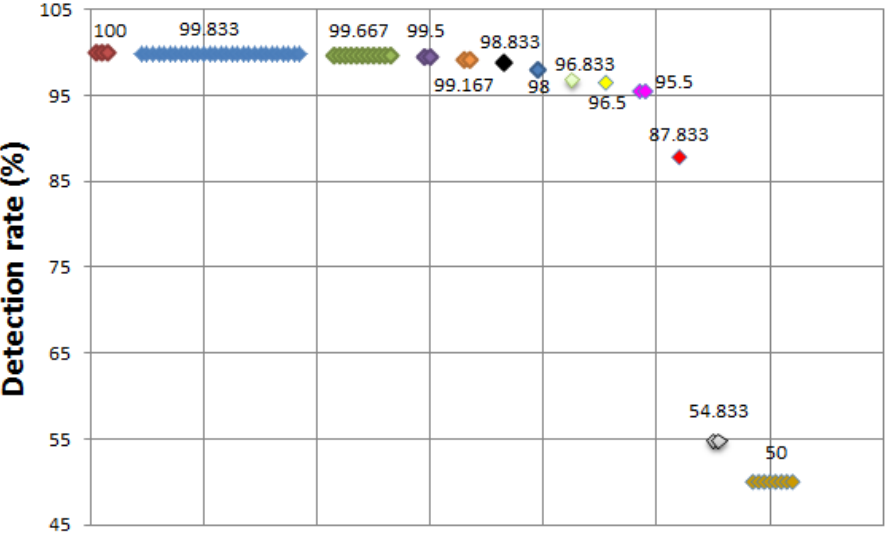
Figure 8. SYN flood attack—detection rate (after